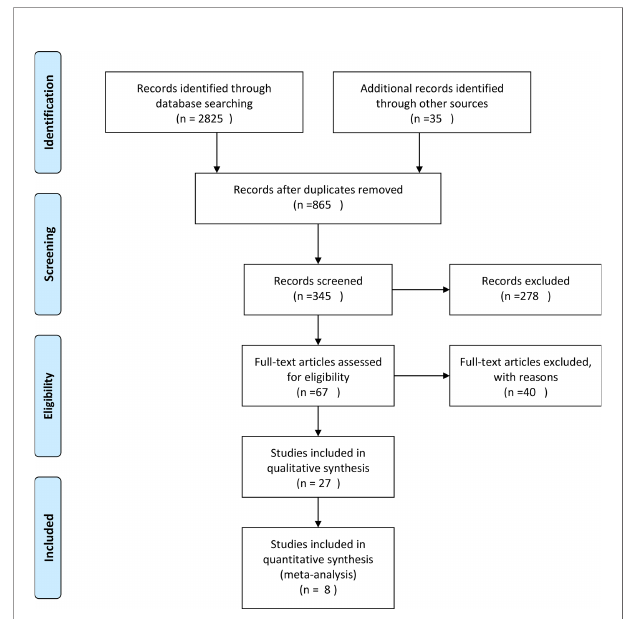
FIGURE 1 | PRISMA Flow